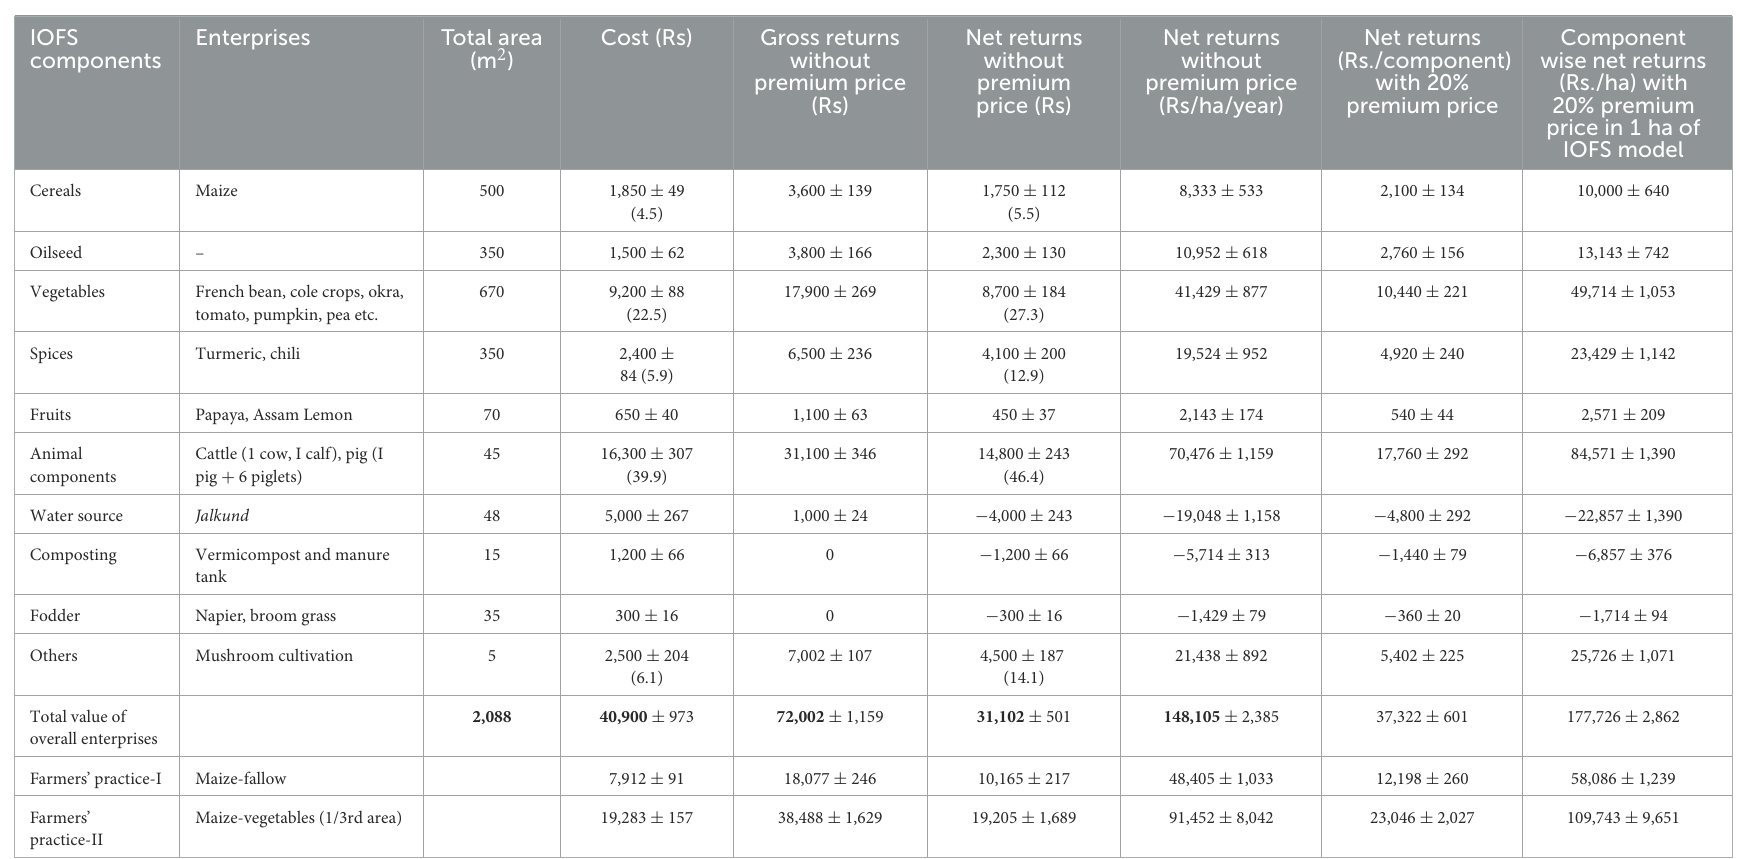
TABLE 4 Detailed analysis of the IOFS model developed at Mrs. Skola Kurbah’s farm (average of 5 years). IOFS